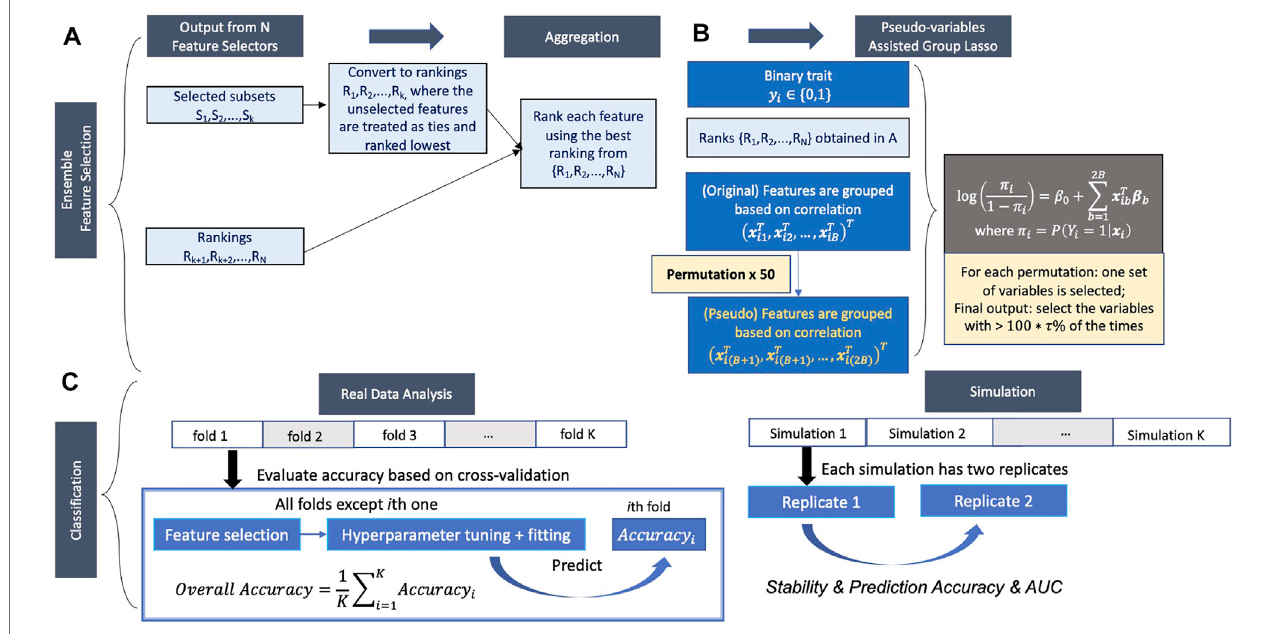
FIGURE 1 | Proposed pipeline. (A,B) Ensemble feature selection. (A) Feature selection based on different methods and aggregation of selected features. (B) Pseudo-variables assisted group lasso. (C) Classi fi